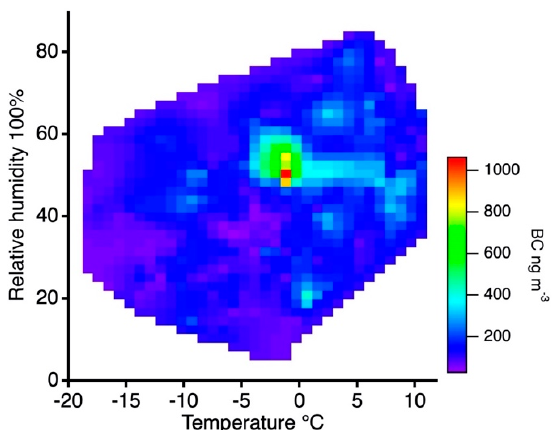
Figure 6. The relationship of BC concentration, temperature, and relative humidity.